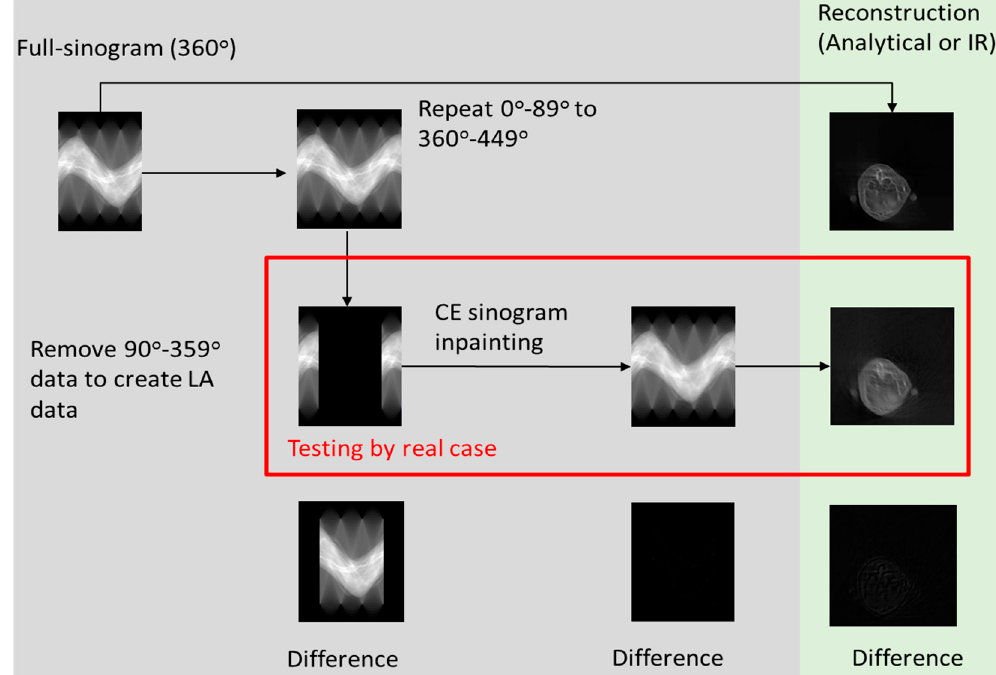
Figure 3. The flowchart of two-step reconstruction of the CT image by LA sinogram inpaint based method.